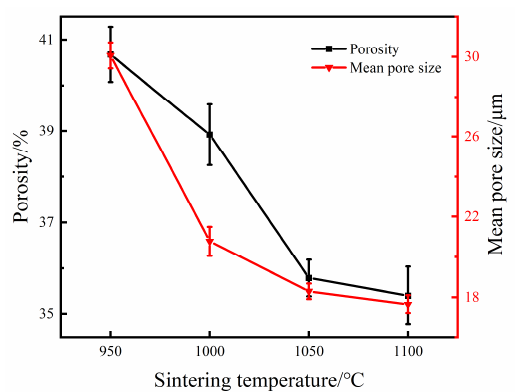
Figure 4. The relation of porosity and average pore size with sintering temperature.